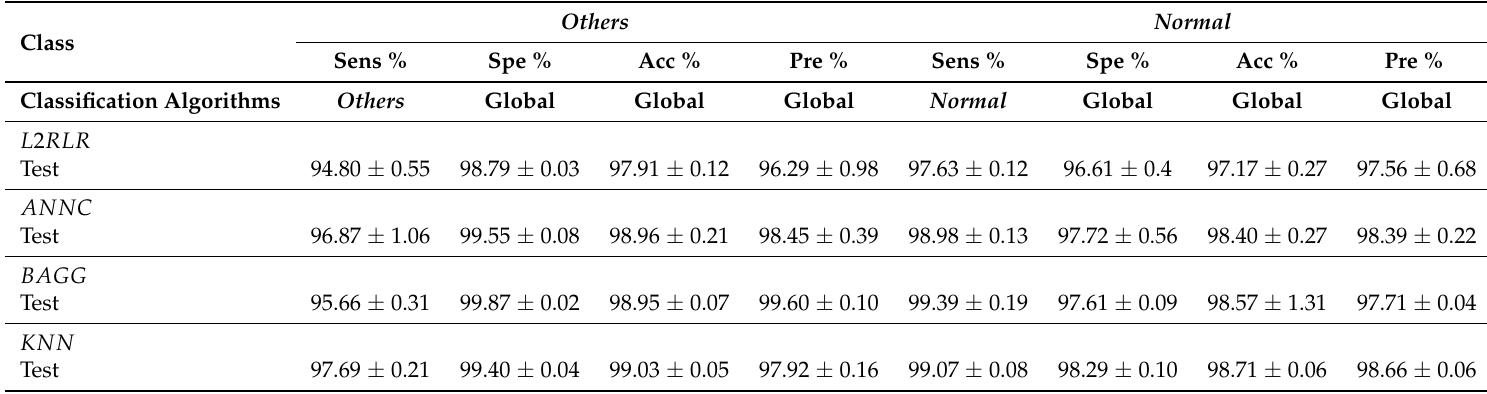
Table 2. Results for individual algorithms ANNC , BAGG , L 2 RLR , and KNN using as input the TFRI used to characterize and detect Others and Normal